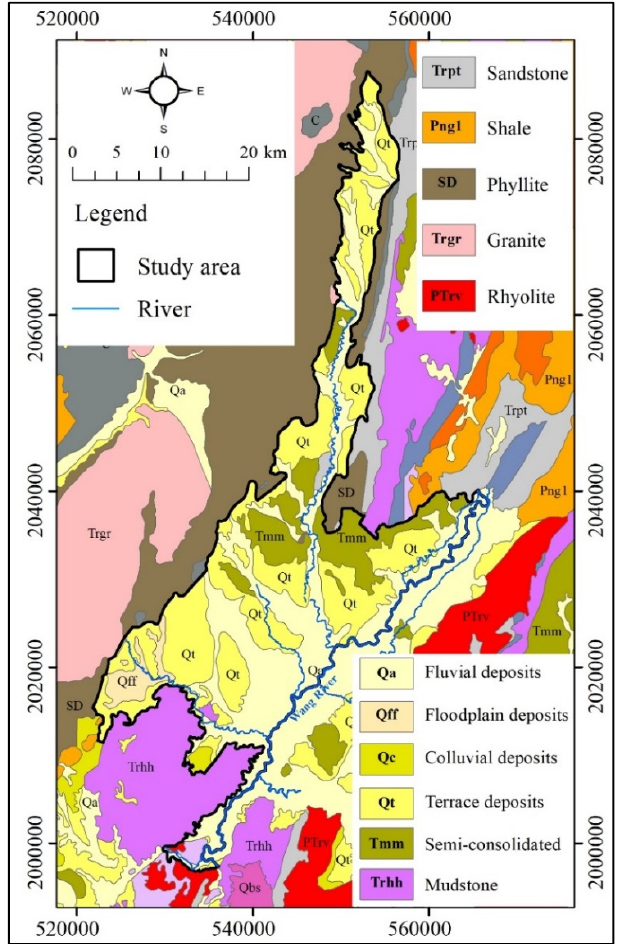
Figure 2. Geologic map of Lampang Basin (modified from [29]).